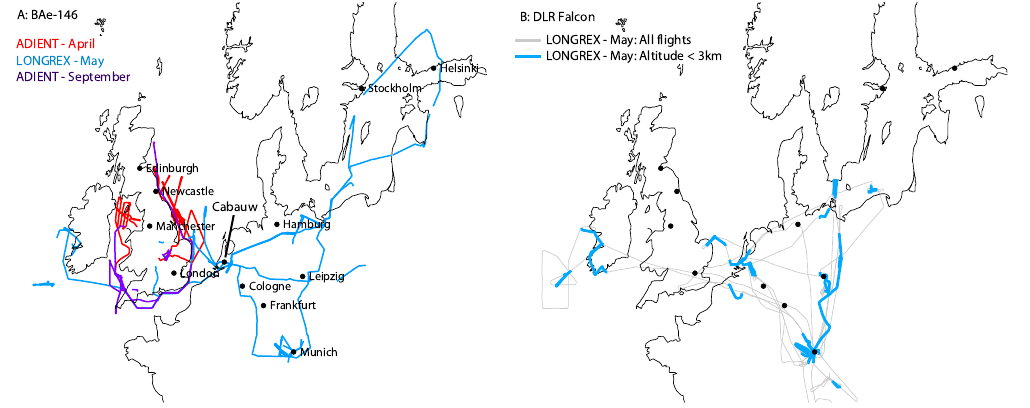
Fig. 1. Map showing flight tracks (restricted to altitudes below 3km) during the April and September 2008 ADIENT and May 2008 EUCAARI-LONGREX measurement periods for the FAAM BAe-146 research aircraft and flight tracks during May 2008 for the DLR Falcon research aircraft. Portions of the DLR Falcon flight tracks falling below 3km are